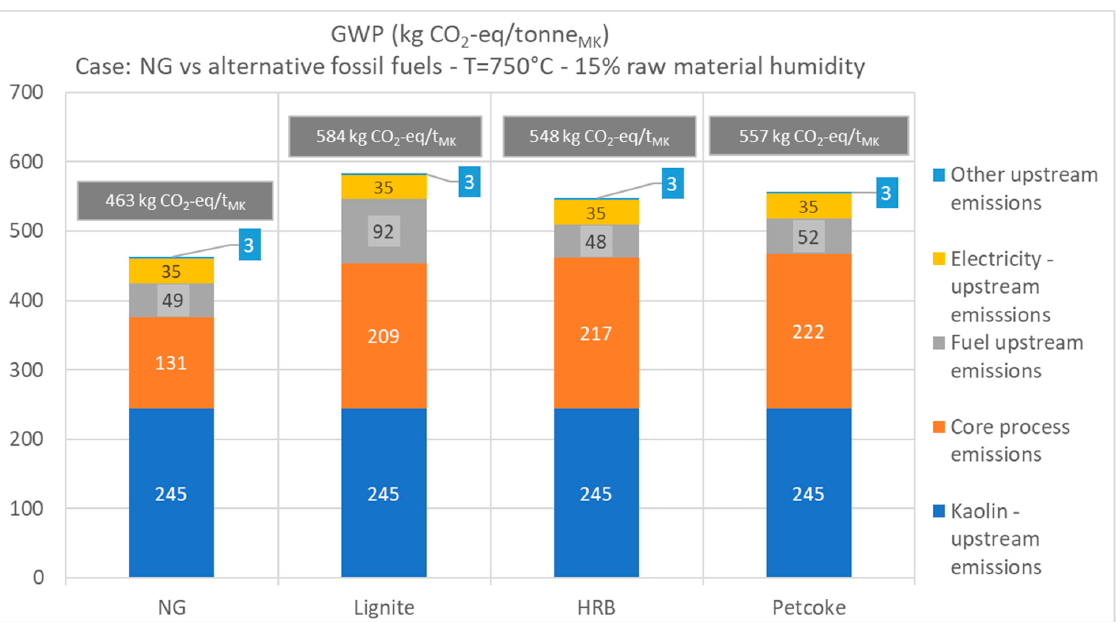
Figure 12. Influence of exhaust gas recirculation on the lifecycle GWP.